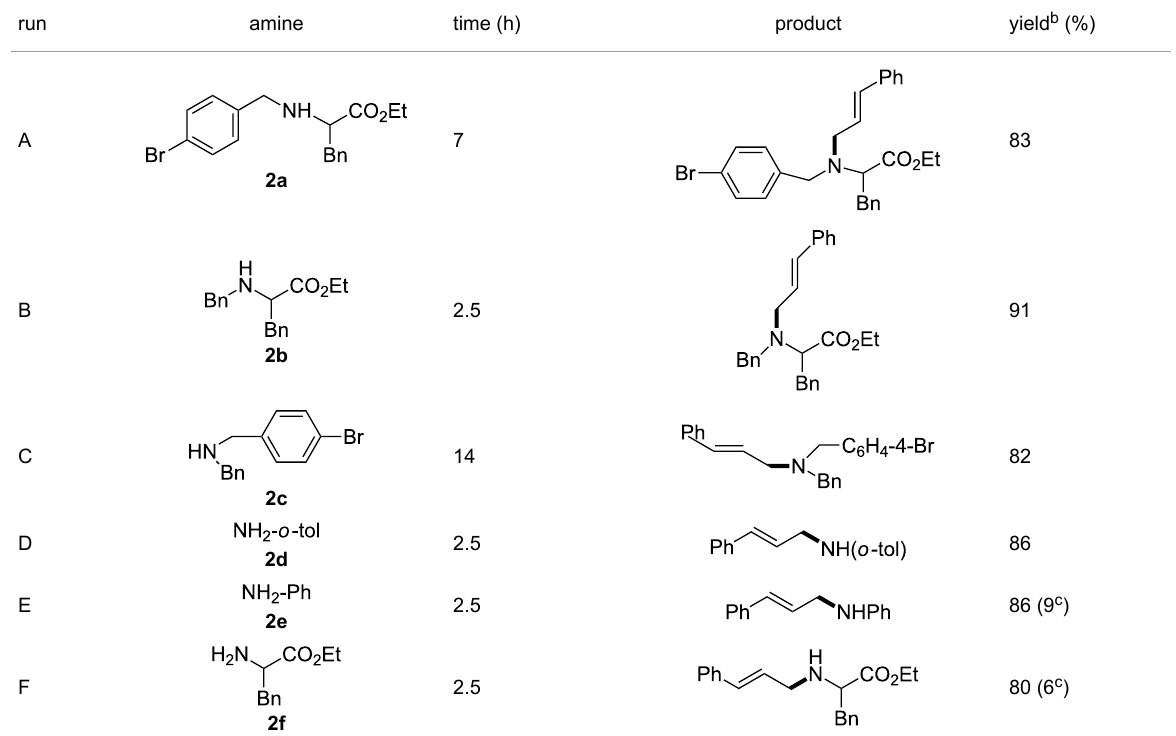
Table 3: Reaction of amines 2a – f with trans -cinnamyl phenyl ether a . run